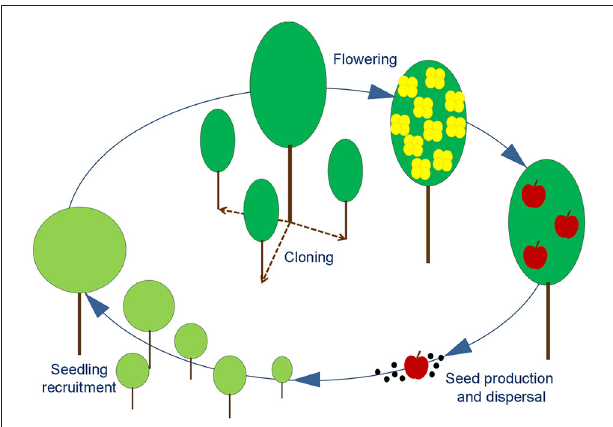
FIGURE 1 | Schematic representation of an angiosperm life cycle. Adult plant can produce new individuals either by vegetative propagation (dashed line) or by reproduction (solid line). The stages of Flowering, Seed production, Seedling recruitment and Cloning are easily detectable with field surveys and used to identify the main bottlenecks for generation